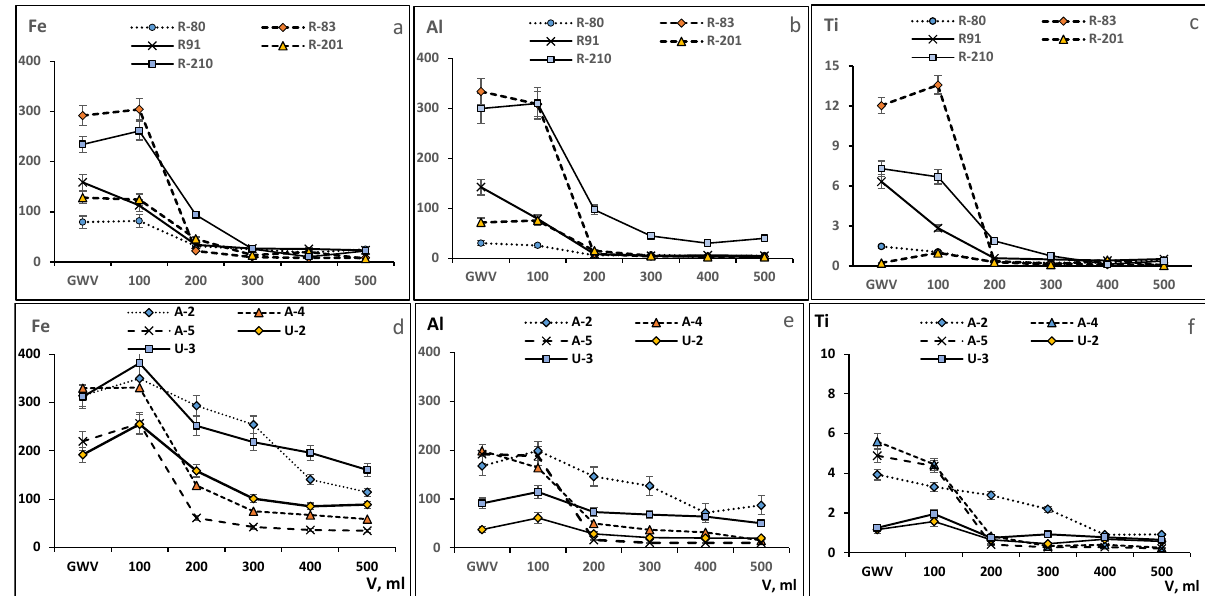
Figure 3. The concentration of Fe ( a , d ), Al ( b , e ), and Ti ( c , f ) (µg/L) in filtrates obtained at the capsules (GWV) after 500 mL and Millipore membranes after filtration of 100, 200, 300, 400, 500 mL for waters from Razdolnaya R. (upper panel) and Amur R./Ussuri R. (lower panel). Bars on Figures 3–5 reflect standard errors of analysis.